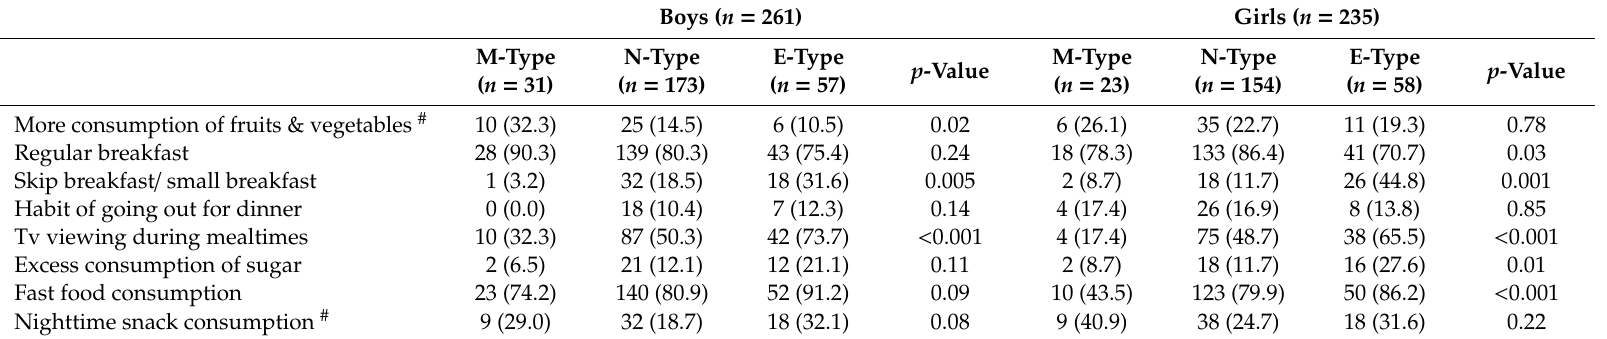
Table 2. The Di ff erences in specific eating habits across